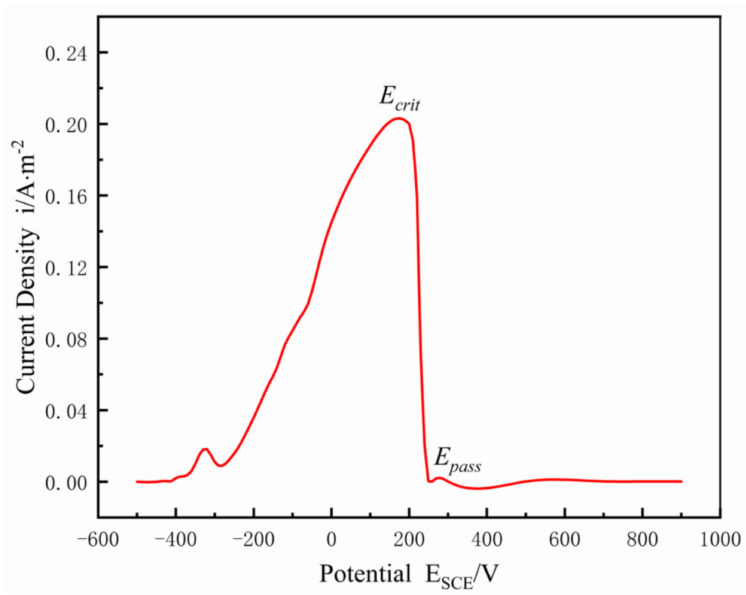
Figure 14. Anodic polarization curve of X100 in 0.5 mol/L Na 2 SO 4 saturated CO 2 solution at 20 ◦ C.